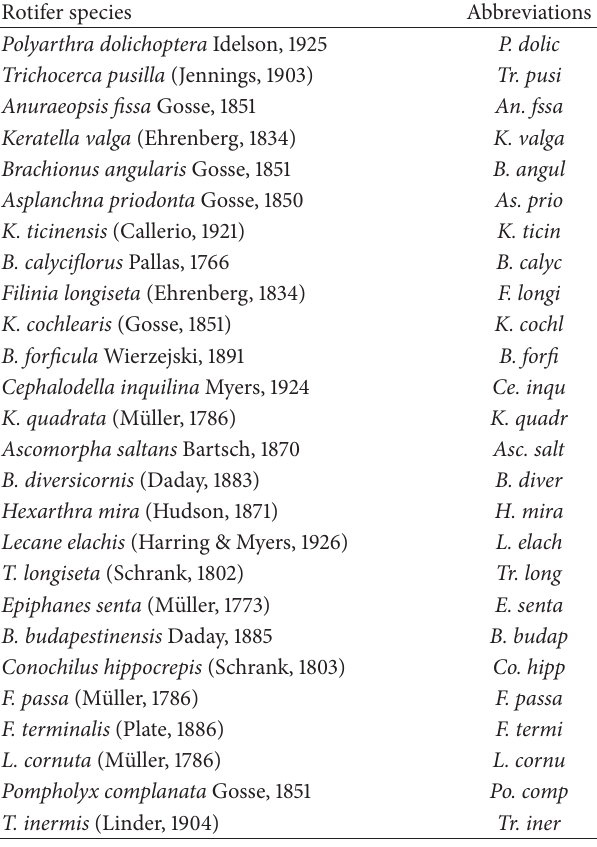
Table 1: Abundant species in Dadian Lake from 2006 to 2009 (in abundance order).